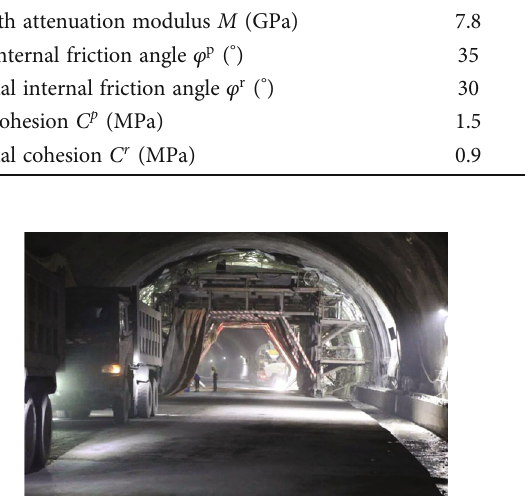
Figure 4: Construction site drawing of tunnel